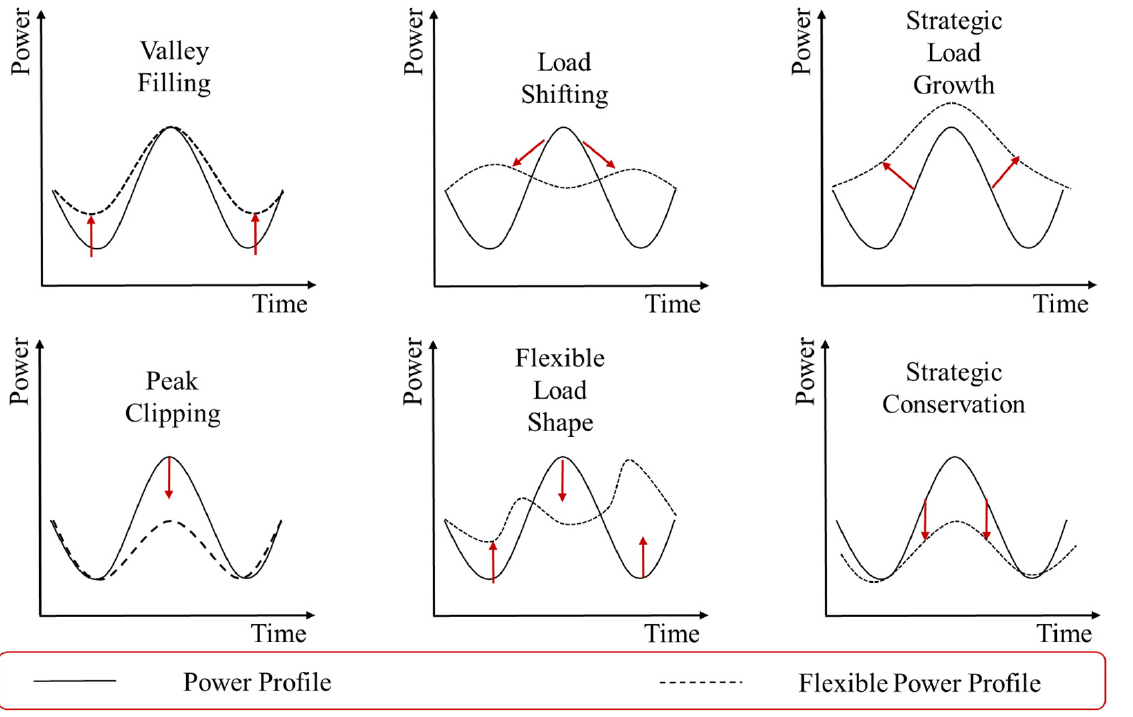
Figure 2. Demand-side management programs in smart grid systems [34].